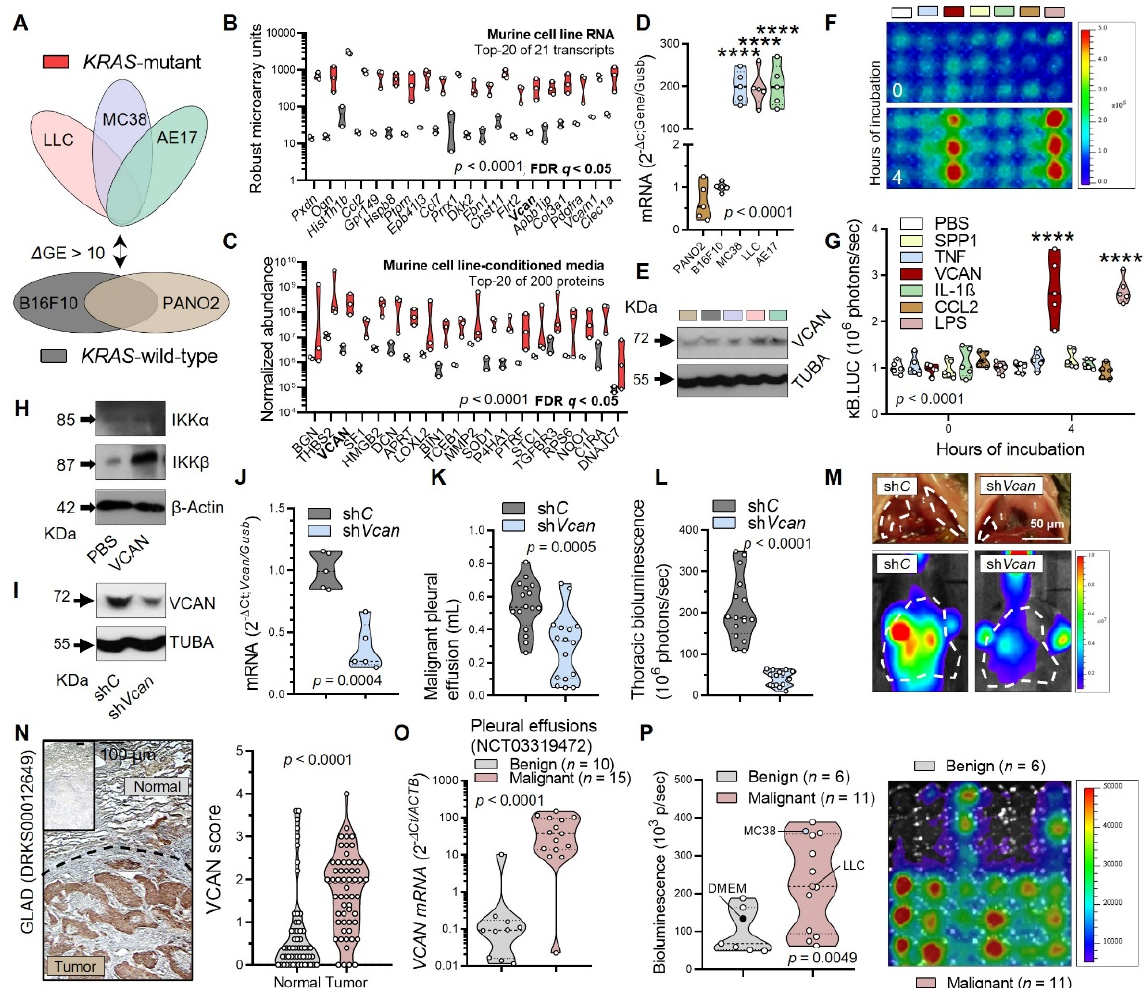
Figure 4. Tumor-secreted versican drives macrophage IKK β , metastasis, and is a cancer biomarker. ( A – E ) Kras -mutant and wild-type cancer cell RNA and supernatants were subjected to microarray and LC-MSMS analyses, respectively. Shown are the experimental design ( A ), top-20 over-represented transcripts ( B ) and secretory proteins ( C ), and Vcan /VCAN mRNA/protein expression ( D , E ). n = 2–3/group; P , probability, two-way ANOVA; Bold letters, false discovery rate (FDR) q < 0.05 compared with Kras -wild-type cells, two-stage linear step-up procedure of Benjamini, Hochberg, and Yekutieli. ( F , G ) Representative bioluminescent images ( F ) and data summary ( G ) from p NGL RAW264.7 cells exposed to lipopolysaccharide (LPS; 1 µ g/mL) or recombinant proteins (1–2 nM). n = 5/group; P , probability, two-way ANOVA; ****, p < 0.0001 compared with other groups, Bonferroni post-tests. ( H ) Immunoblots of mouse BMDM exposed to VCAN. n = 5/group. ( I – M ) LLC cells stably expressing control (sh C ) and anti- Vcan (sh Vcan ) shRNA were validated and injected intrapleurally into NGL mice. Shown are immunoblots ( I ), Vcan mRNA expression ( J ), and data summaries ( K , L ) and representative photographic and bioluminescent images ( M ) taken 14 days post-tumor cells. ( I , J ) n = 5/group; ( K – M ) n = 16/group; P , probability, unpaired Student’s t -test. ( N ) Images and data summary of VCAN expression of n = 41 tumor/normal tissue pairs from patients with resected lung adenocarcinoma. ( O ) VCAN mRNA expression of 10 benign and 15 malignant pleural effusions. ( P ) Data summary and representative image of bioluminescence of p NGL RAW264.7 cells after expo- sure to benign ( n = 6; top triplicates) and malignant ( n = 11; bottom triplicates) pleural effusions and tumor-conditioned media (each triplicate column is one patient). ( N – P ) P , probability, unpaired Student’s t -test. ( B – D , G , J – L , N – P ) Shown are raw data (circles), kernel density distributions (vio- lins), and medians/quartiles (dashed/dotted lines). The uncropped blots are shown in Figure S12. 3.4. Myeloid IKKB as the VCAN Accessory To identify the IKK responsible for NF- κ B signaling in macrophages, we silenced the four main IKKs (encoded by the murine Chuk , Ikbkb , Ikbke , and Tbk1 genes) in RAW264.7 macrophages and identify IKK β as the main mediator of NF- κ B activation in these cells (Figure 5A,B). To further define myeloid IKK β functions, we obtained BMDM from